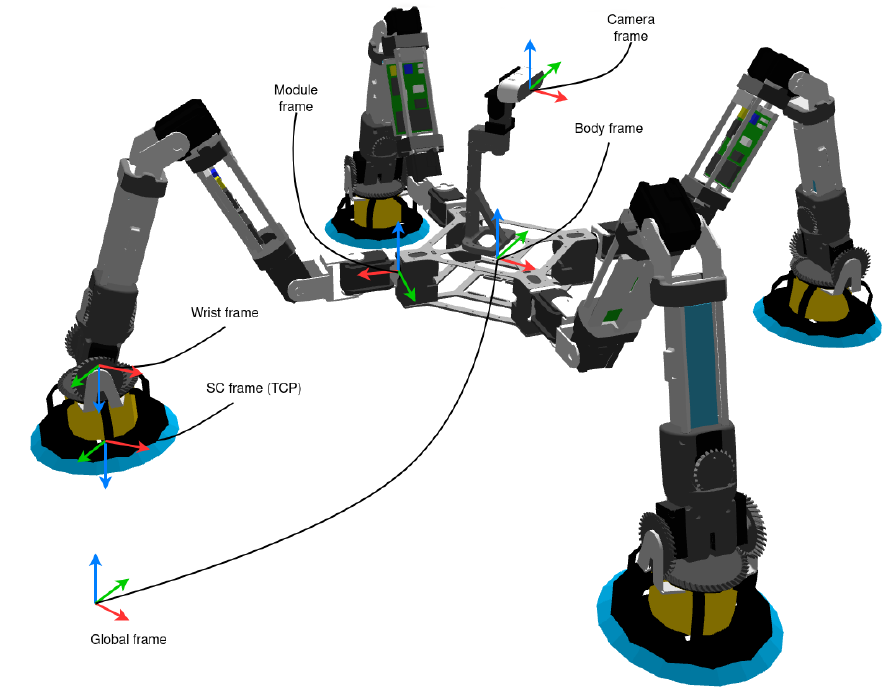
Figure 6. Organism